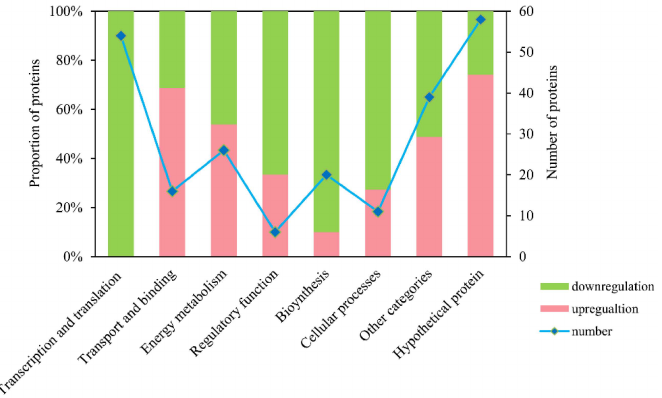
Figure 5. Number and proportion of differentially abundant proteins classified into eight func- tional categories in Microcystis aeruginosa FACHB-905 upon phosphorus depletion. Proteins were assigned into functional categories according to CyanoBase (http://genome.microbedb.jp/cyanobase (accessed on 5 April 2016)) and GO annotation. Proteins with more than a 1.5-fold change ( ≥ 1.5 (upregulation) or ≤ 0.67 (downregulation)) containing at least two unique peptides and a p -value below 0.05 were recognized as significantly differentially abundant proteins. Pink columns repre- sent upregulation and green columns represent downregulation. Blue line with diamond symbol represents the number of differentially abundant